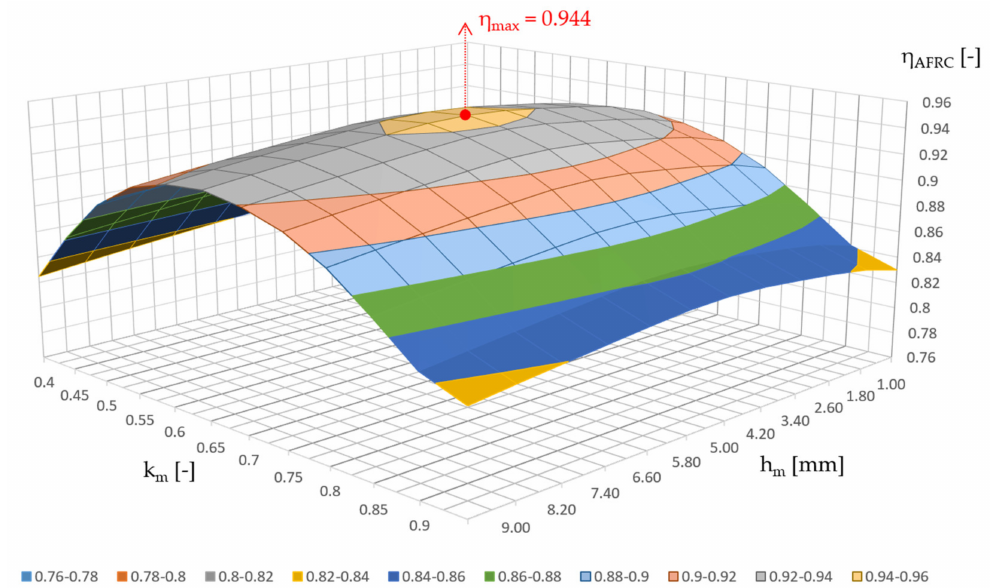
Figure 4. Overall efficiency η of the optimized AFRC unit evaluated in a 3D plot as a function of the active surface area represented by parameter k m and thickness h m for constant-width w m permanent